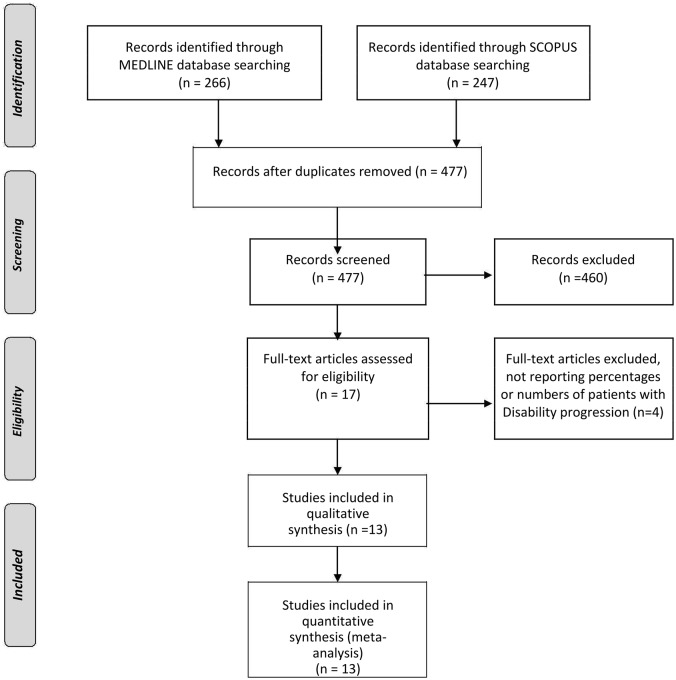
Flow chart presenting the selection of eligible studies.